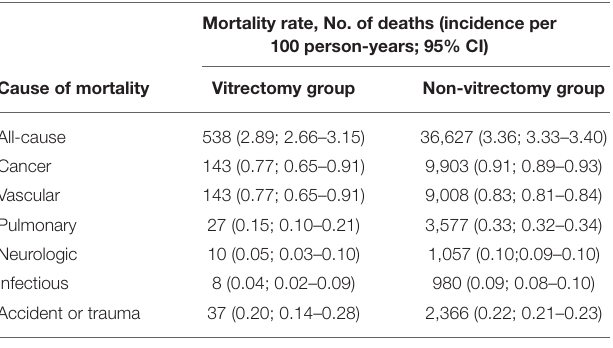
TABLE 1 | Mortality rates of elderly patients with vitreoretinal disease stratified by vitrectomy status. Mortality rate, No. of deaths (incidence per 100 person-years; 95%